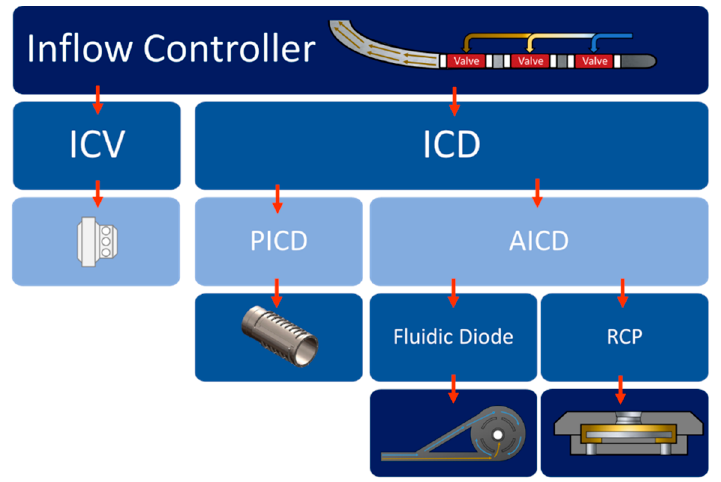
Figure 5. Schematic representation of the types of inflow controllers to reduce water and gas production.